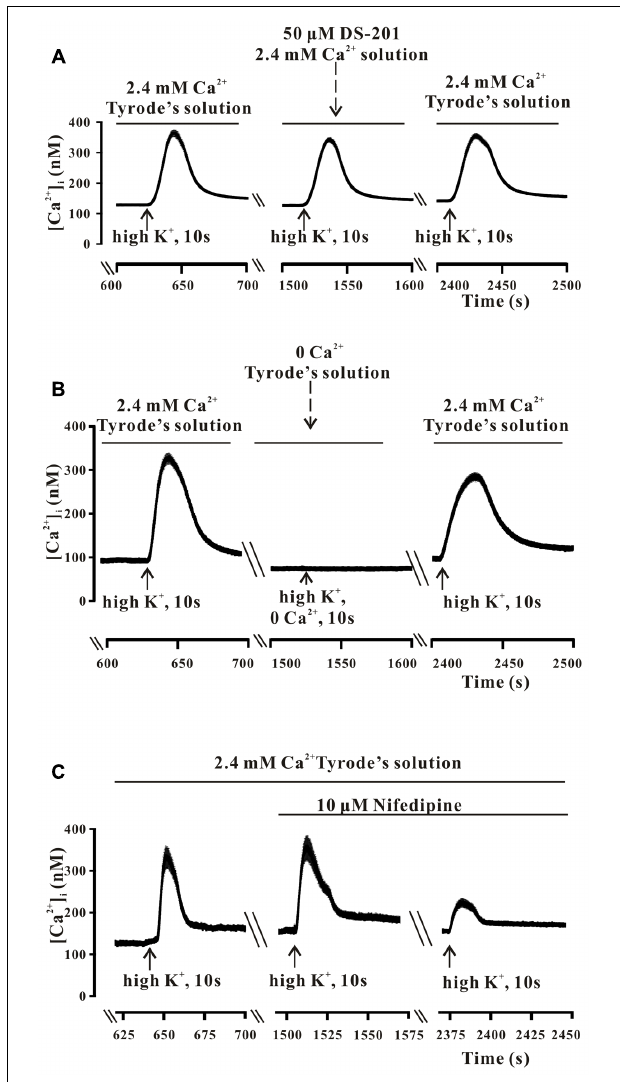
FIGURE 3 | The high K + -induced intracellular Ca 2 + transients in the mesenteric VSMCs of rats. (A) The typical recordings show that high K + (60 mM) did not affect the high K + -induced intracellular Ca 2 + transients. The data were obtained from 13 cells in one measurement. (B) The typical recordings show that high K + could induce Ca 2 + transient only in the presence of extracellular Ca 2 + . The data were obtained from 28 cells in one measurement. (C) The typical recordings show that the high K + -induced intracellular Ca 2 + transients were sensitive to the L-type Ca 2 + channel blocker, Nifedipine (10 µ M). The data were obtained from 18 cells in one measurement.